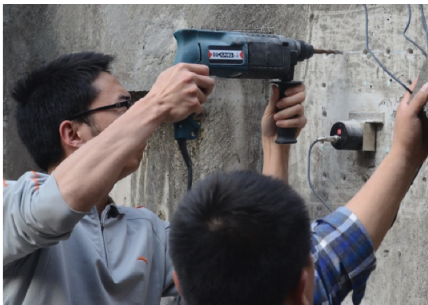
Figure 3: Simulation of partial damage in the wind-break wall.